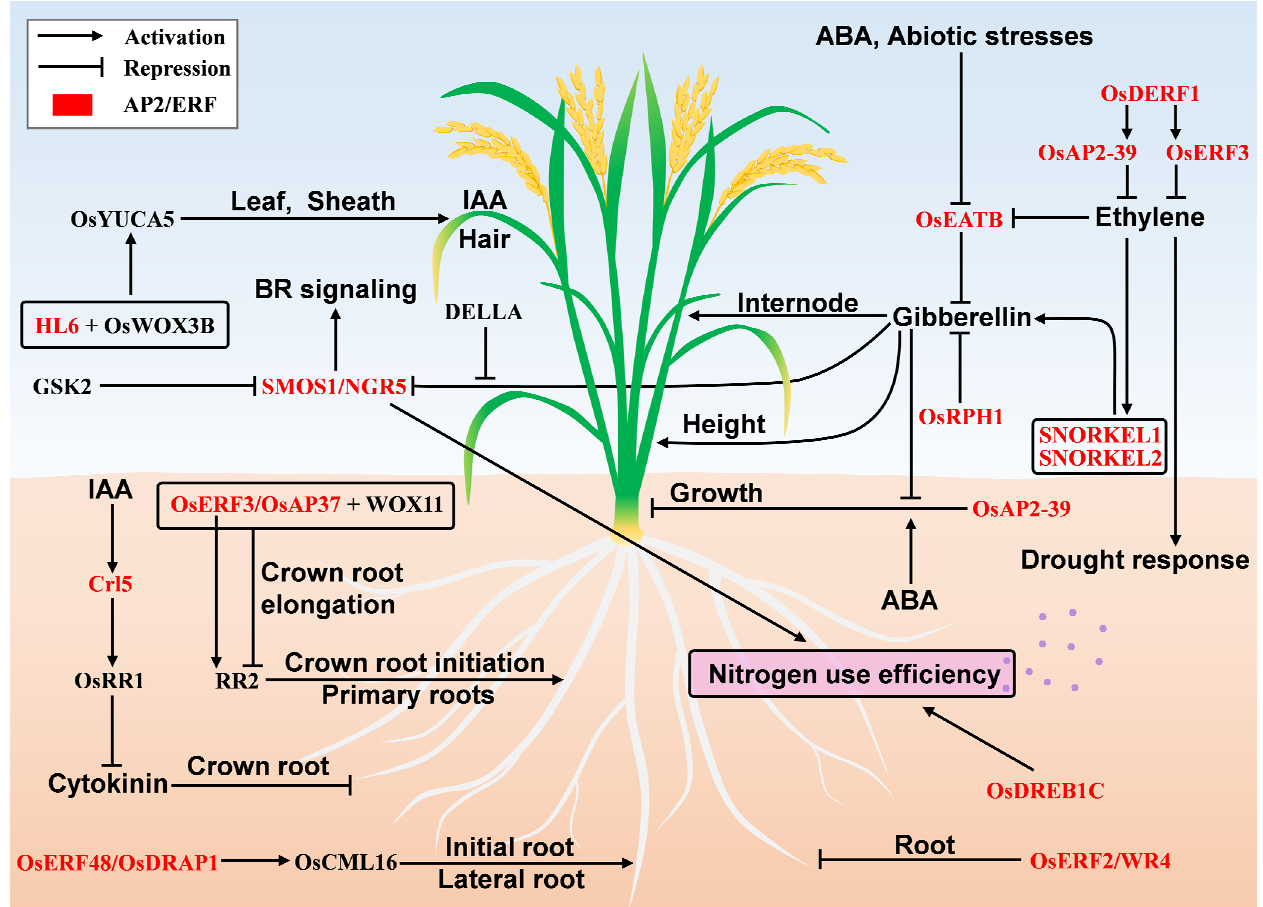
Figure 4. Schematic representation of development, phytohormones and nutrient use efficiency regulation mediated by AP2/ERF transcription factors in rice. In Section 3.5, OsERF3/OsAP37 , Crl5 and OsERF48/OsDRAP1 are described as affecting root initiation and formation. In Section 3.6, HL6, OsEATB, OsERF2/WR4, OsRPH1, SMOS1/NGR5, SNORKEL1, SNORKEL2, OsDERF1, OsAP2-39 and OsERF3 are described to regulate various growth processes of plants by participating in phytohormone pathways. SMOS1/NGR5 and OsDREB1C promote rice nitrogen use efficiency, as described in Section 3.7. The AP2/ERF transcription factors and other regulators are shown in red and black, respectively. Abbreviations: indole-3-acetic acid, IAA; abscisic acid, ABA; gibberellin, GA; brassinosteroid, BR. Table 6. Genes associated with root development in rice.